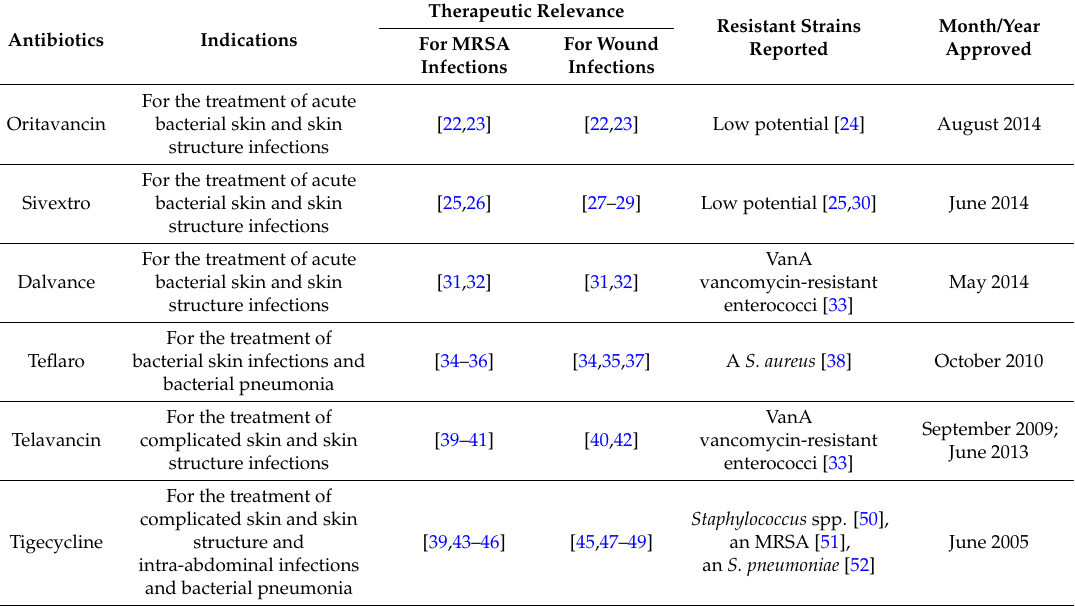
Some U.S. Food and Drug Administration (FDA) approved antibiotics to combat methicillin-resistant Staphylococcus aureus (MRSA) infection